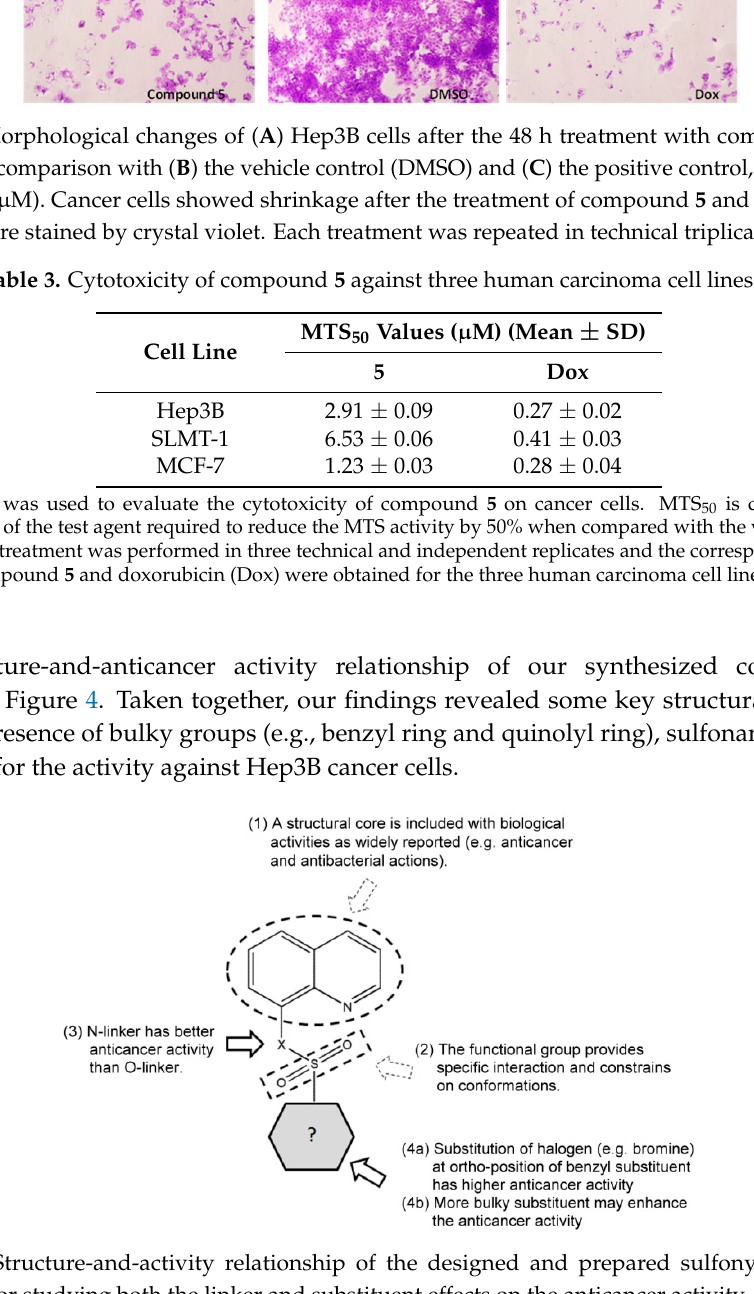
quinolines for studying both the linker and substituent effects on the anticancer Figure 4. Structure-and-activity relationship of the designed and prepared sulfonyl-containing